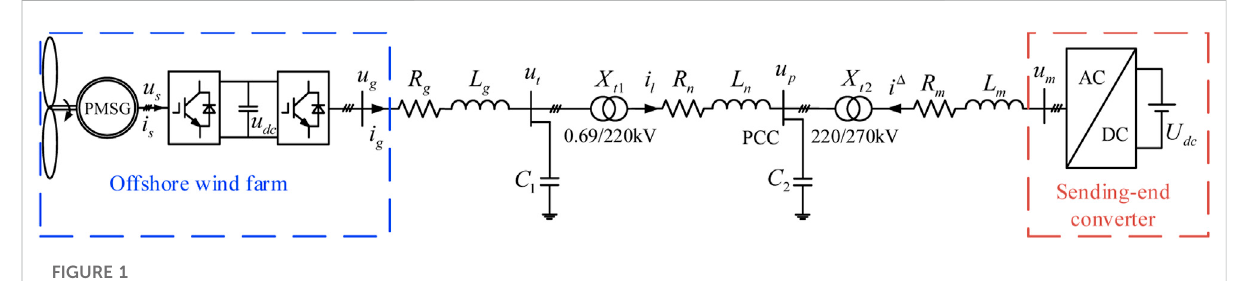
FIGURE 1 Structure diagram of a simpli fi ed